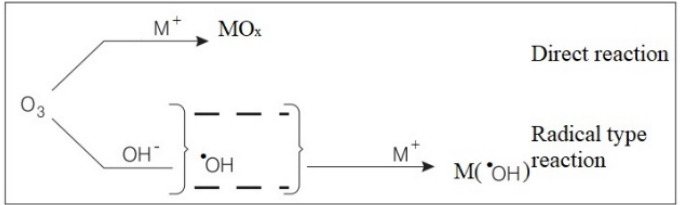
Figure 14. General schematic of reaction for ozonation of contaminants in an aqueous solution (M: metal, MO x : Metal oxide, and • OH: hydroxyl radical). Reproduced from Ref. [88]. Copyright 2001 SciELO.